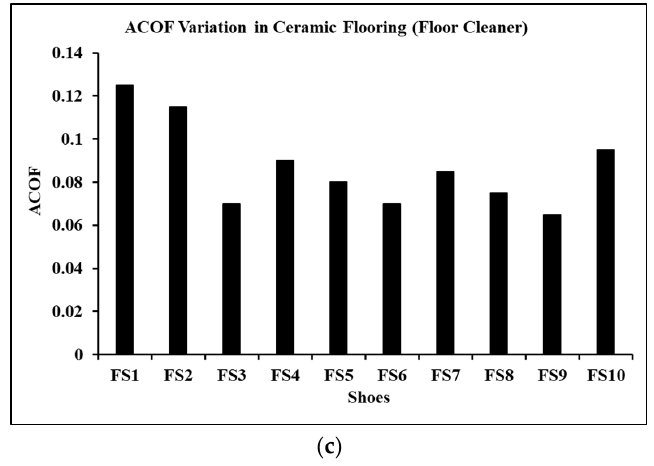
Figure 6. Traction performance of shoes on ceramic flooring in: ( a ) dry condition, ( b ) water ‐ contaminated condition, and ( c ) floor ‐ cleaner ‐ contaminated condition.